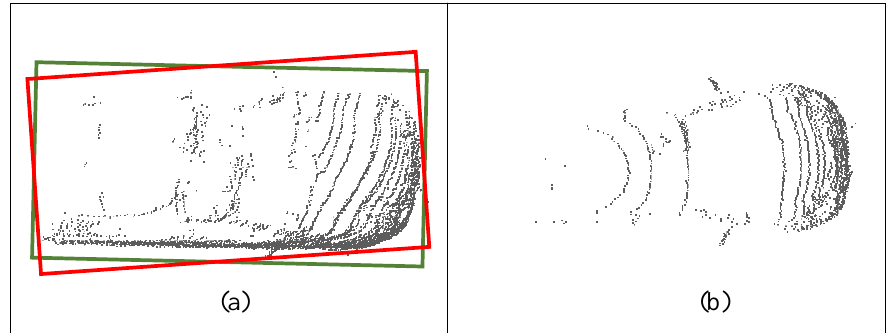
Figure 1. Illustration of point cloud map with different shapes. ( a ) displays the asymmetrical clusters, where the ground truth bounding box is denoted by the green rectangle, and the estimated bounding box is indicated by the red rectangle. ( b ) depicts the symmetrical